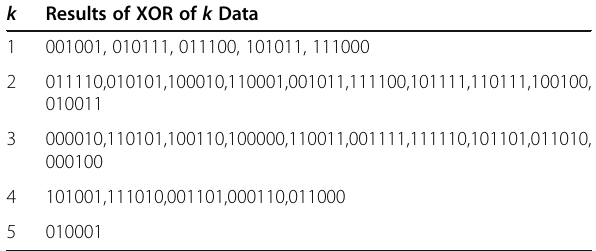
Table 2 Results of XOR of k Data k Results of XOR of k